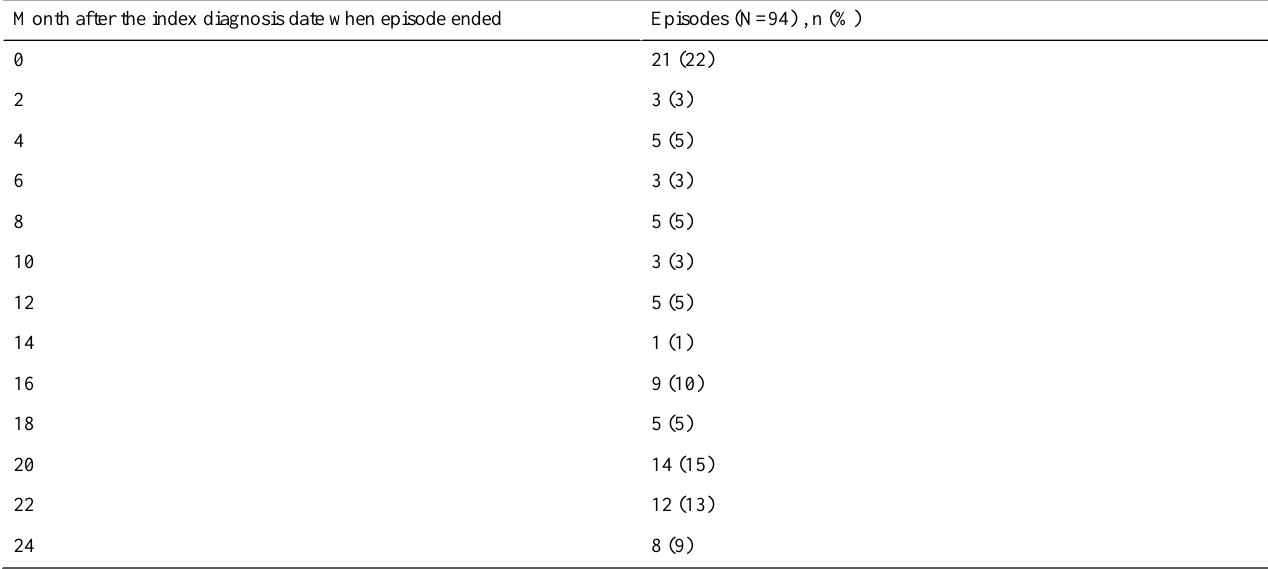
Table 5. Distribution of episode-ending distance from the index diagnosis